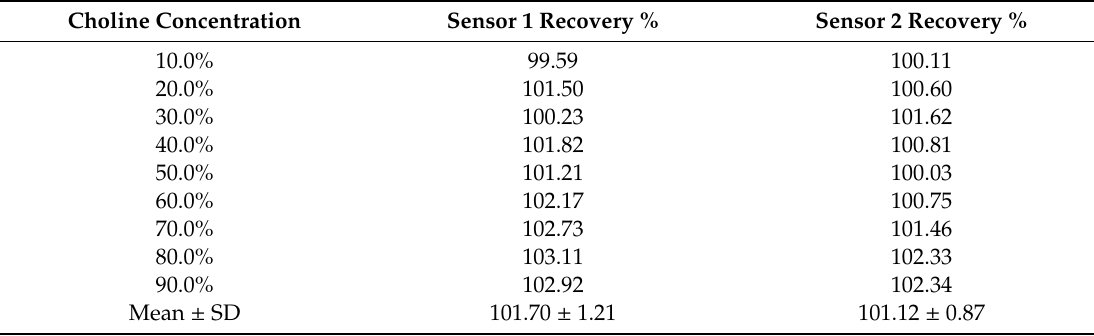
Table 6. Determination of carbachol in presence of its degradation product, choline.